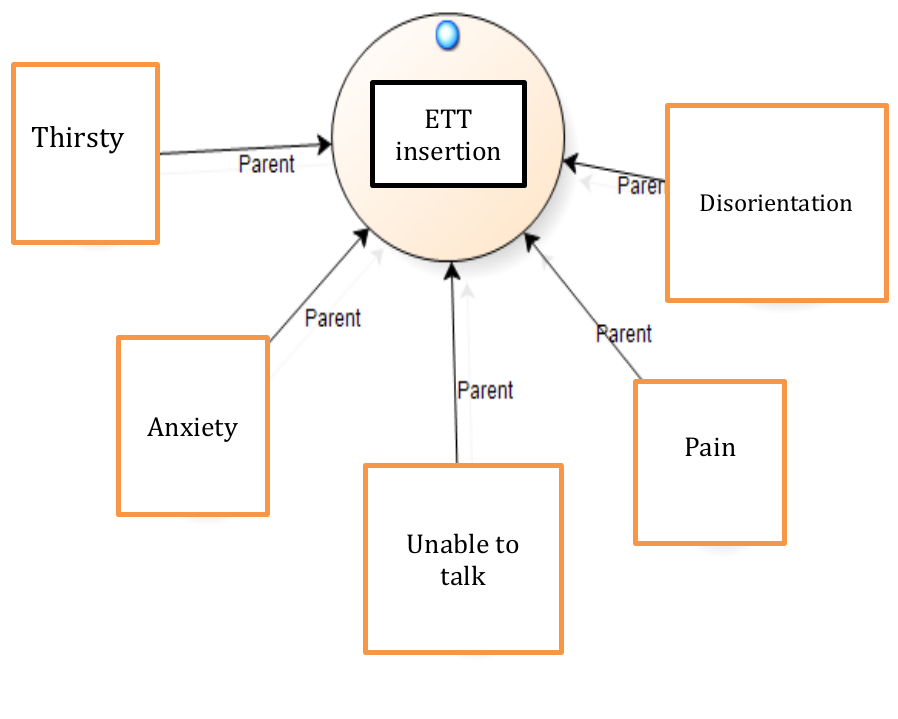
Fig. 1. Scheme of ETT